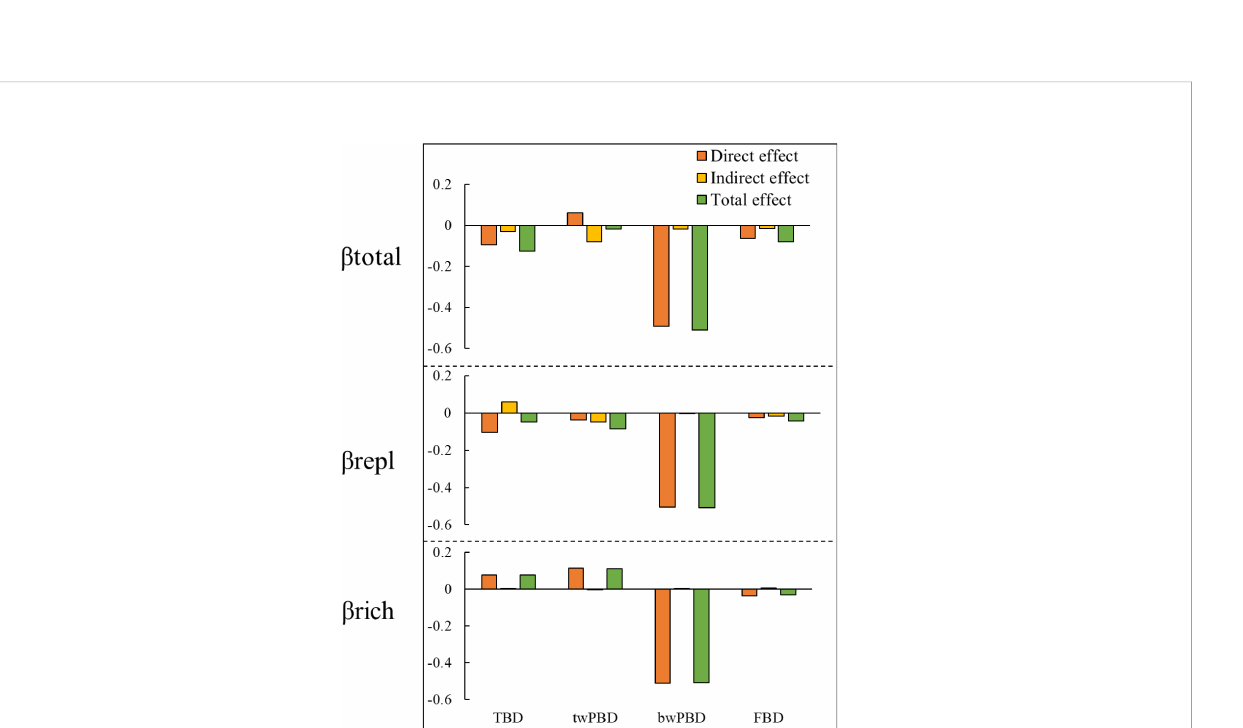
FIGURE 6 Synthesis of the direct, indirect and total effects of mountain roads on b total and its two components. TBD, taxonomic beta diversity; FBD, functional beta diversity; bwPBD, basal-weighted beta diversity; twPBD, tip-weighted phylogenetic beta